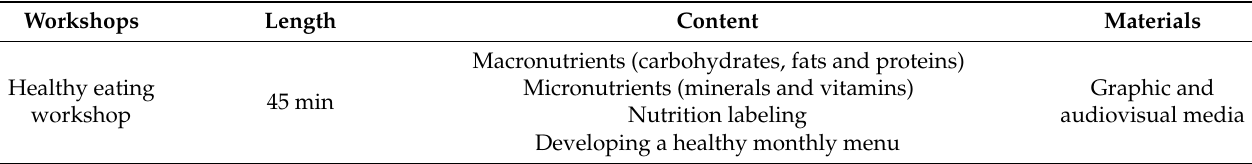
Table 2. Development of workshops aimed at parents or